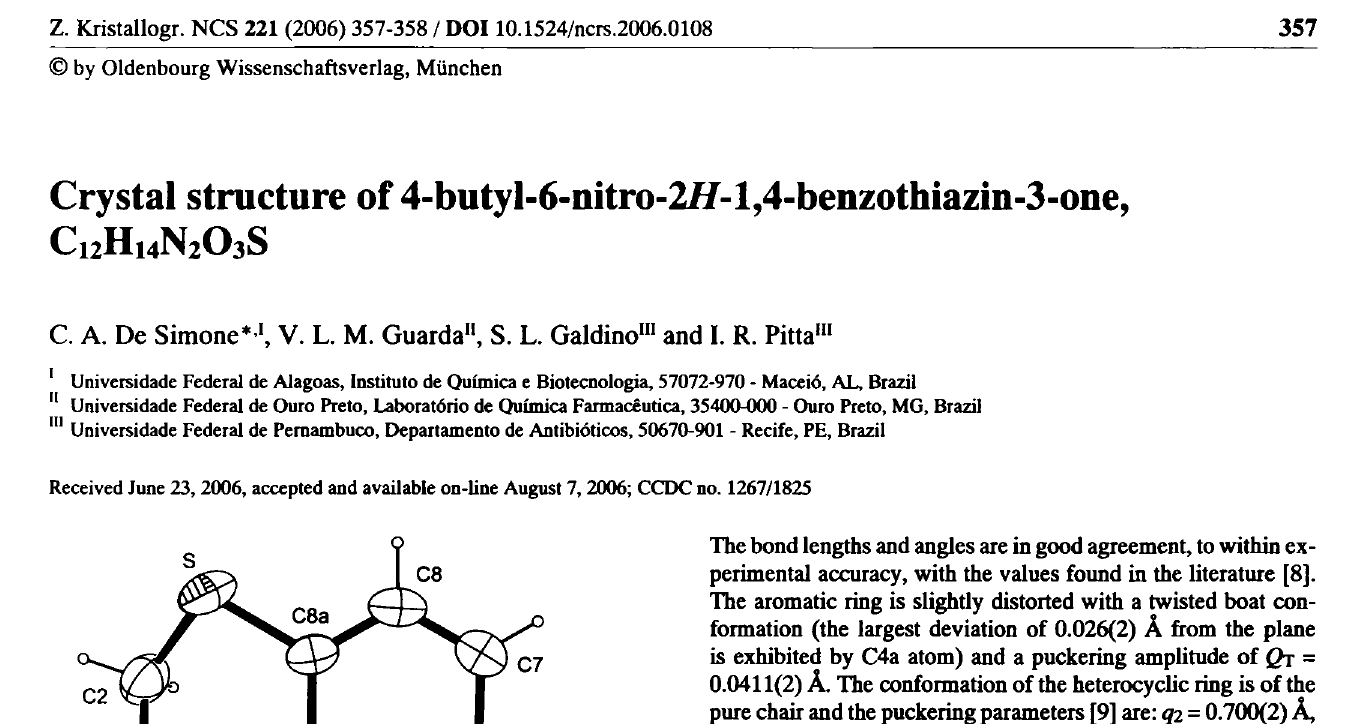
Table 1. Data collection and handling.